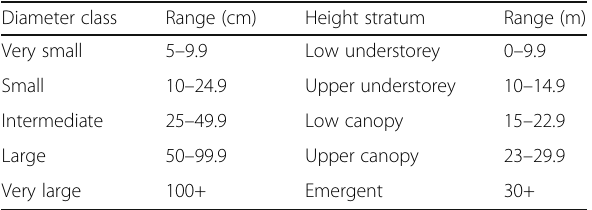
Table 2 Diameter (dbh) classes and height strata used to compare plots in this study Diameter